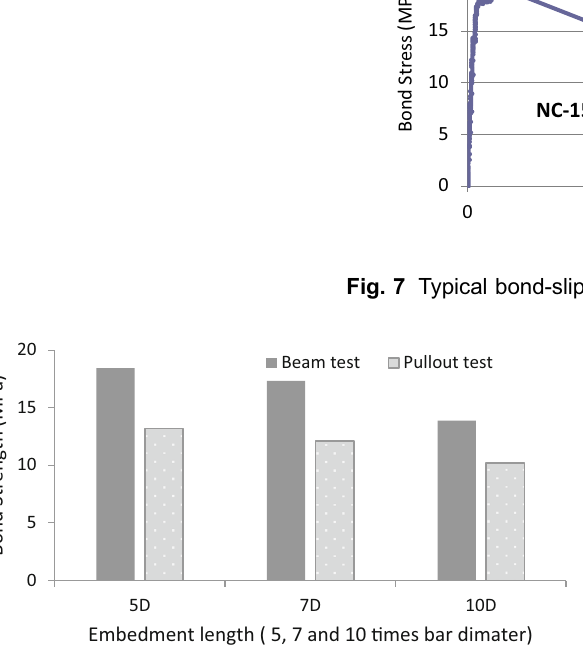
Fig. 8 Comparison of bond strength from beam and pullout